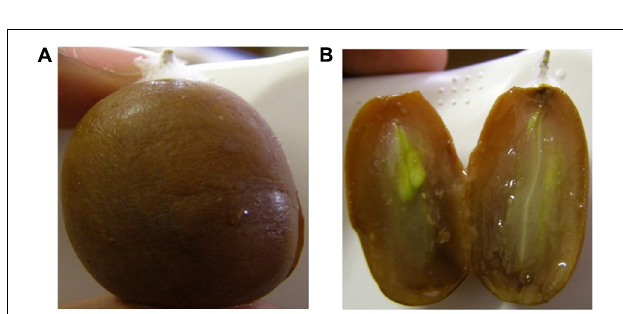
FIGURE 5 | A Regal berry showing chocolate browning on the outside (A) and (B) on the inside caused by a fungal infection.